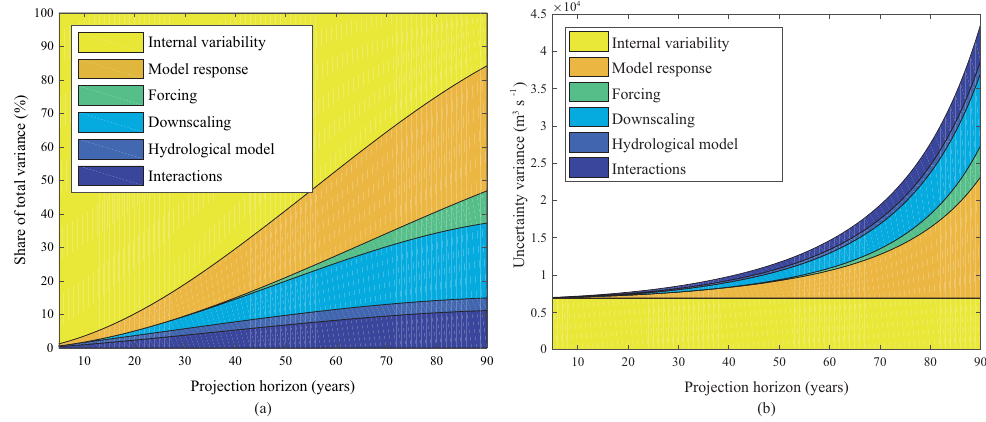
Figure 3. (a) Share of different uncertainty components (variance) for extreme discharge in Rosenheim. (b) Resulting absolute uncertainties for CCLM. Uncertainties that are “visible” in our case study are shaded yellow–orange and “hidden” ones